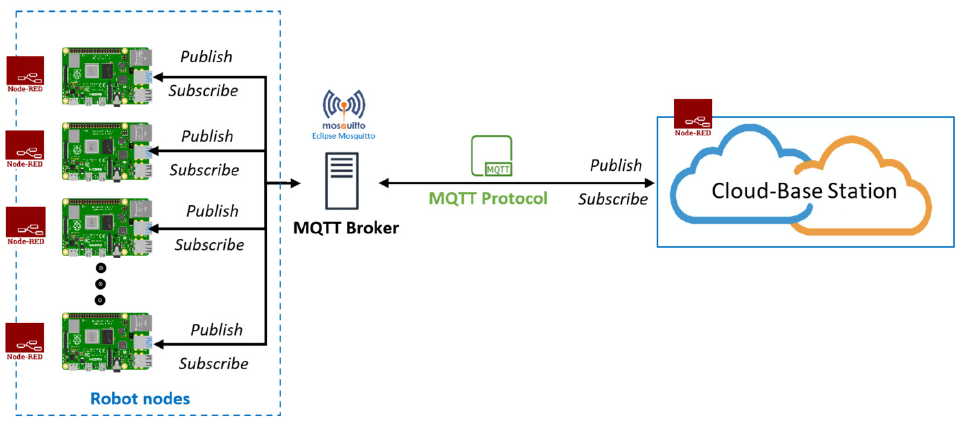
Figure 8. Communication between multiple robot nodes and cloud-based station using MQTT network